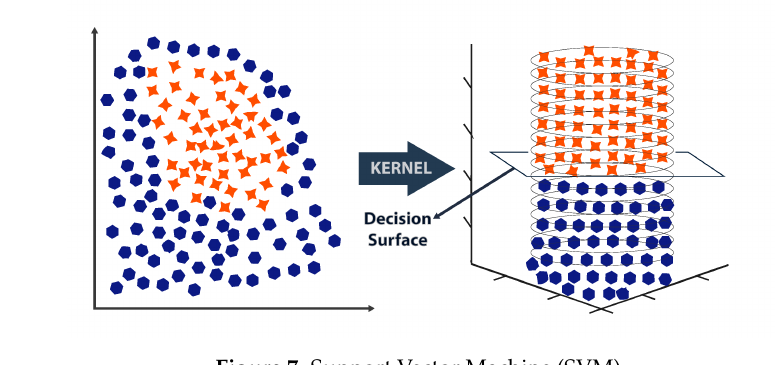
Figure 7. Support Vector Machine (SVM).